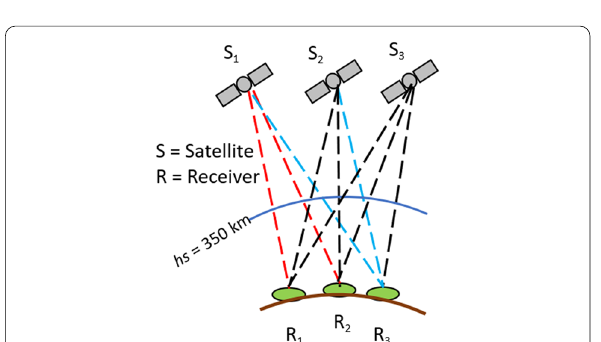
Fig. 3 Mixed-pair method (all colors) is a combination of station-pair method (red dashed lines), and satellite pair (blue dashed lines). hs is the height at which IPP is assumed (the figure is conceptual and not to